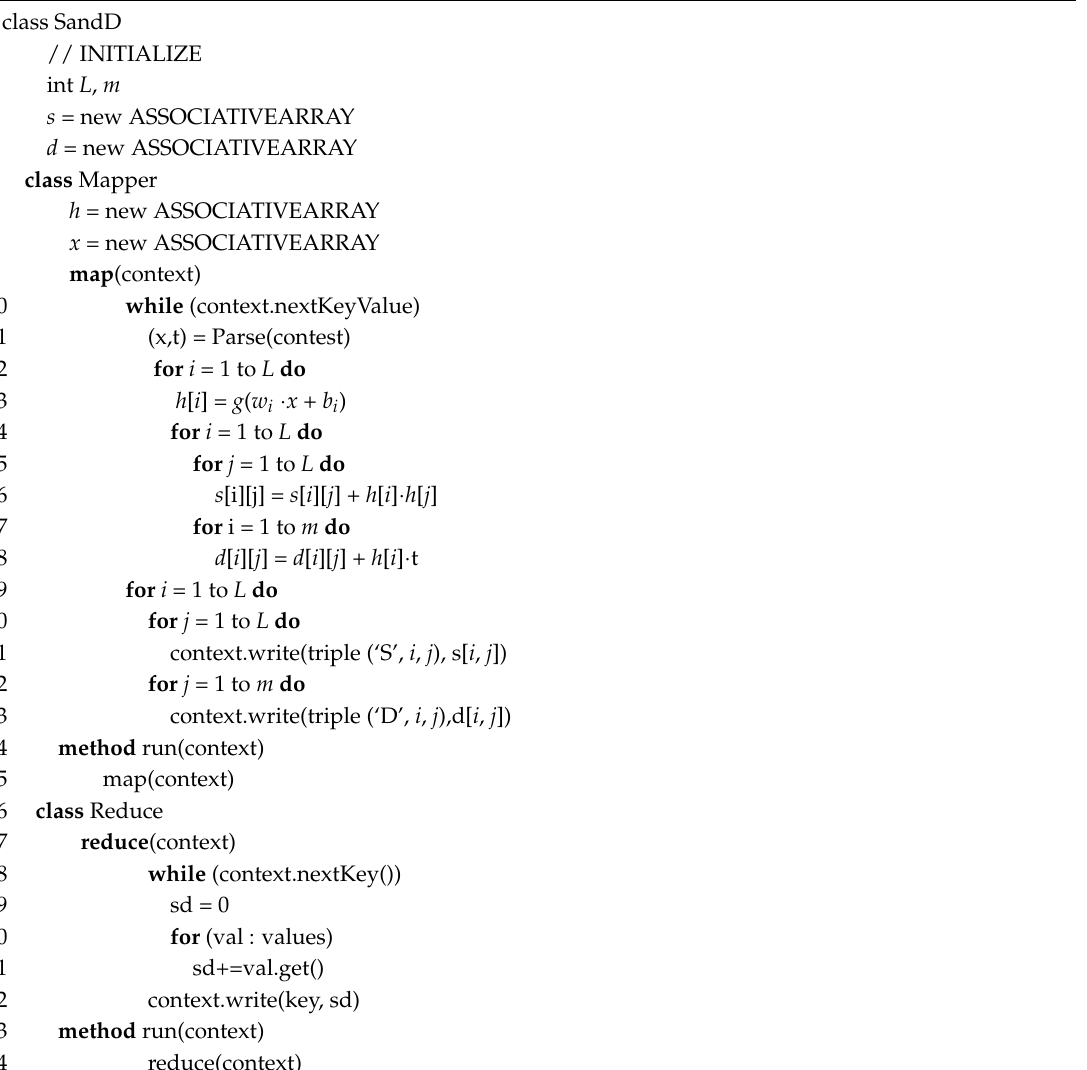
Algorithm 1: Improved Distributed ELM (IDELM) S and D calculation